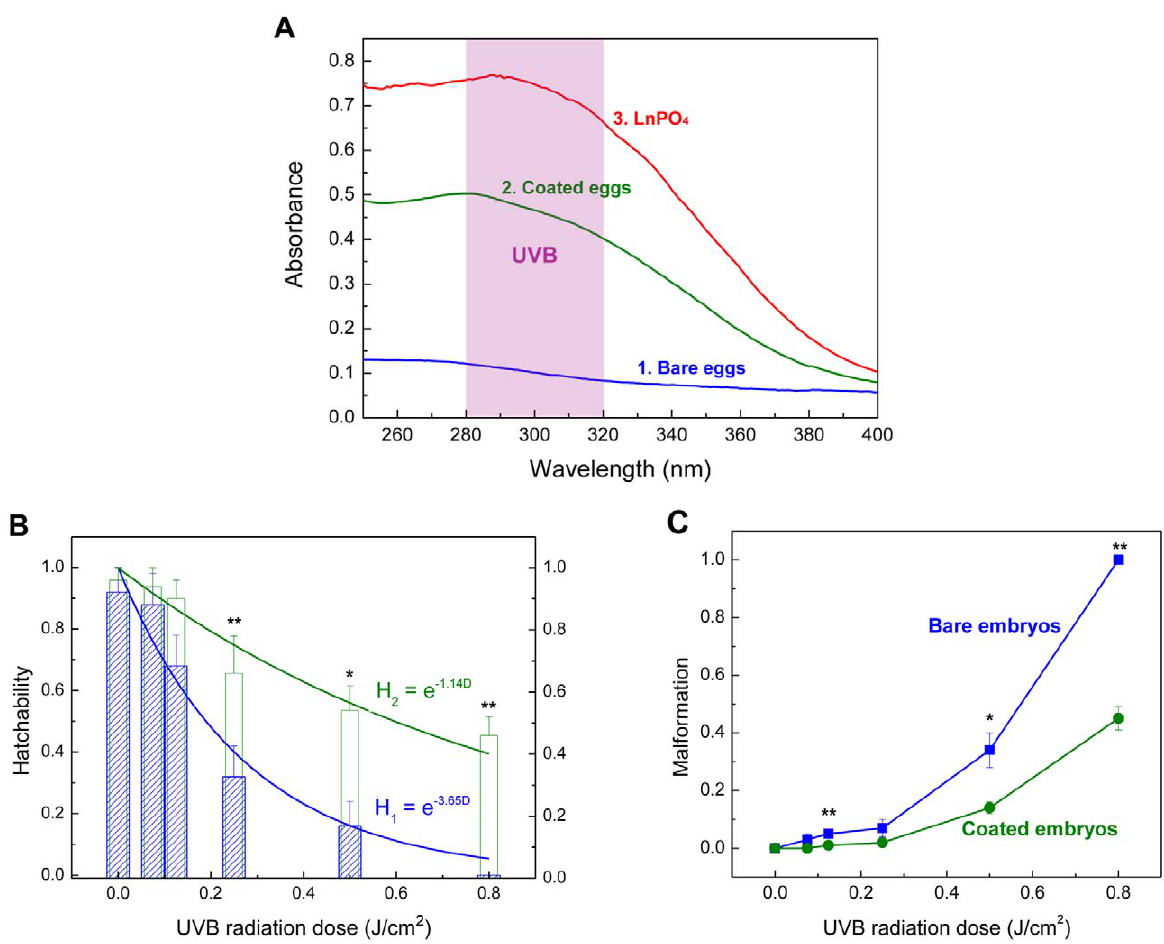
Figure 2. Absorption spectra and the shielding function of the shell. A. Absorption spectra of bare embryo, coated embryo within LnPO 4 shell, and LnPO 4 particles in water (2.4 g/L). B. Hatchability of the bare embryos and the coated ones under different dosage of UVB radiation. (R 12 =0.96; R 22 =0.83). C. Deformity percentage of embryos under different UVB doses in a short-term exposure. (* p , 0.05; ** p , 0.01 by Student’s t- test, mean 6 s.d.,